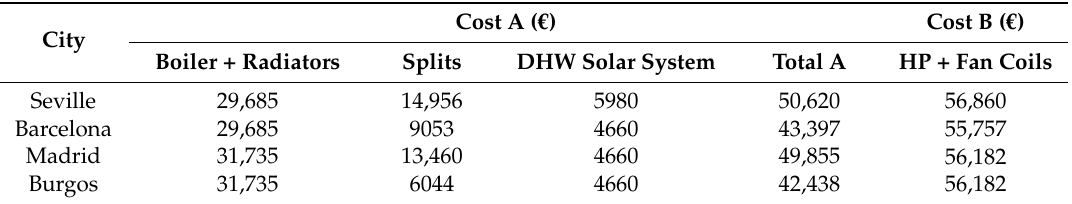
Table 7. Cost of the equipment installed in the building.